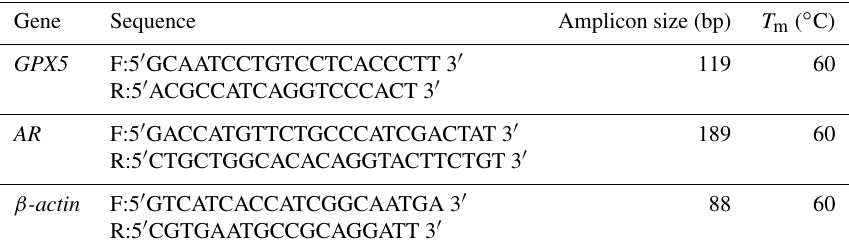
Table 1. Sequence of primers used for RT-PCR. Gene Sequence Amplicon size